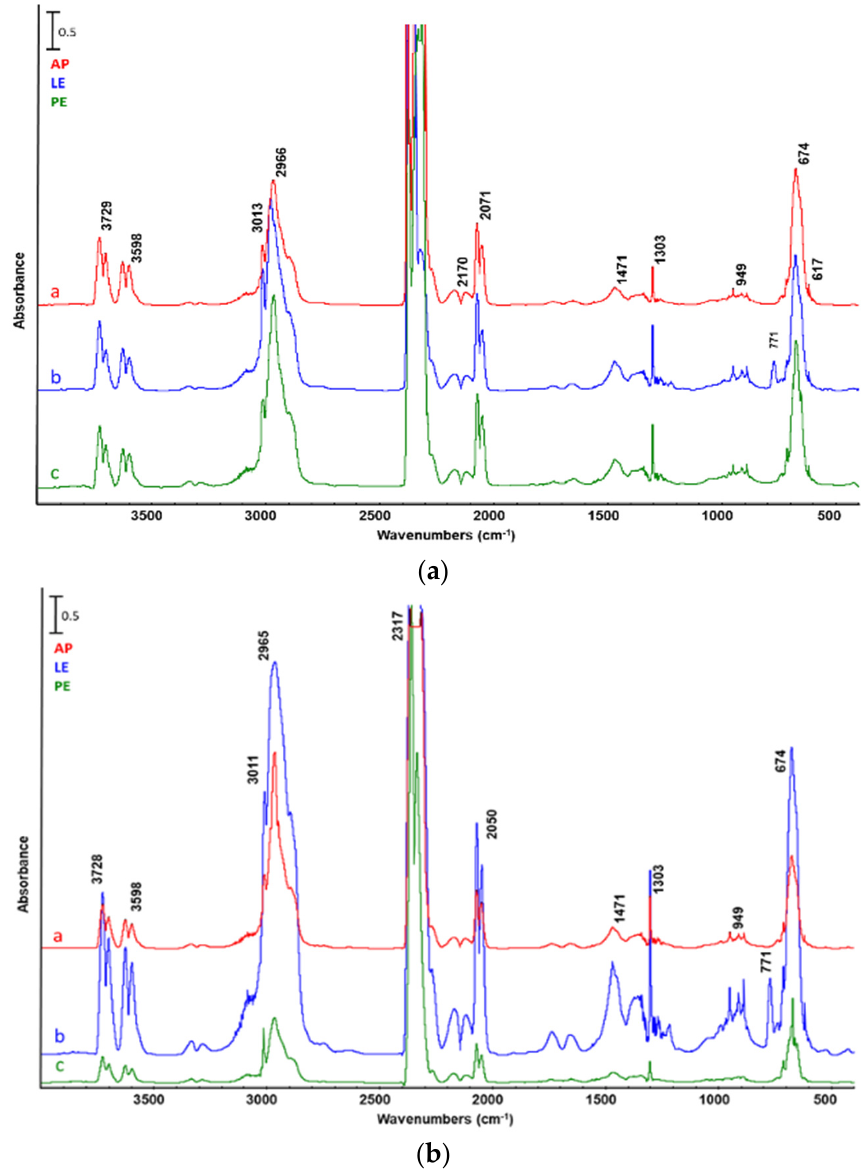
Figure 3. FTIR analysis of reaction gases from the catalytic pyrolysis of a— A. platensis untreated biomass (AP), b—biomass after lipid extraction (LE), and biomass after c—protein extraction (PE). Catalyst: ( a ) ZSM5, ( b ) silica–alumina.